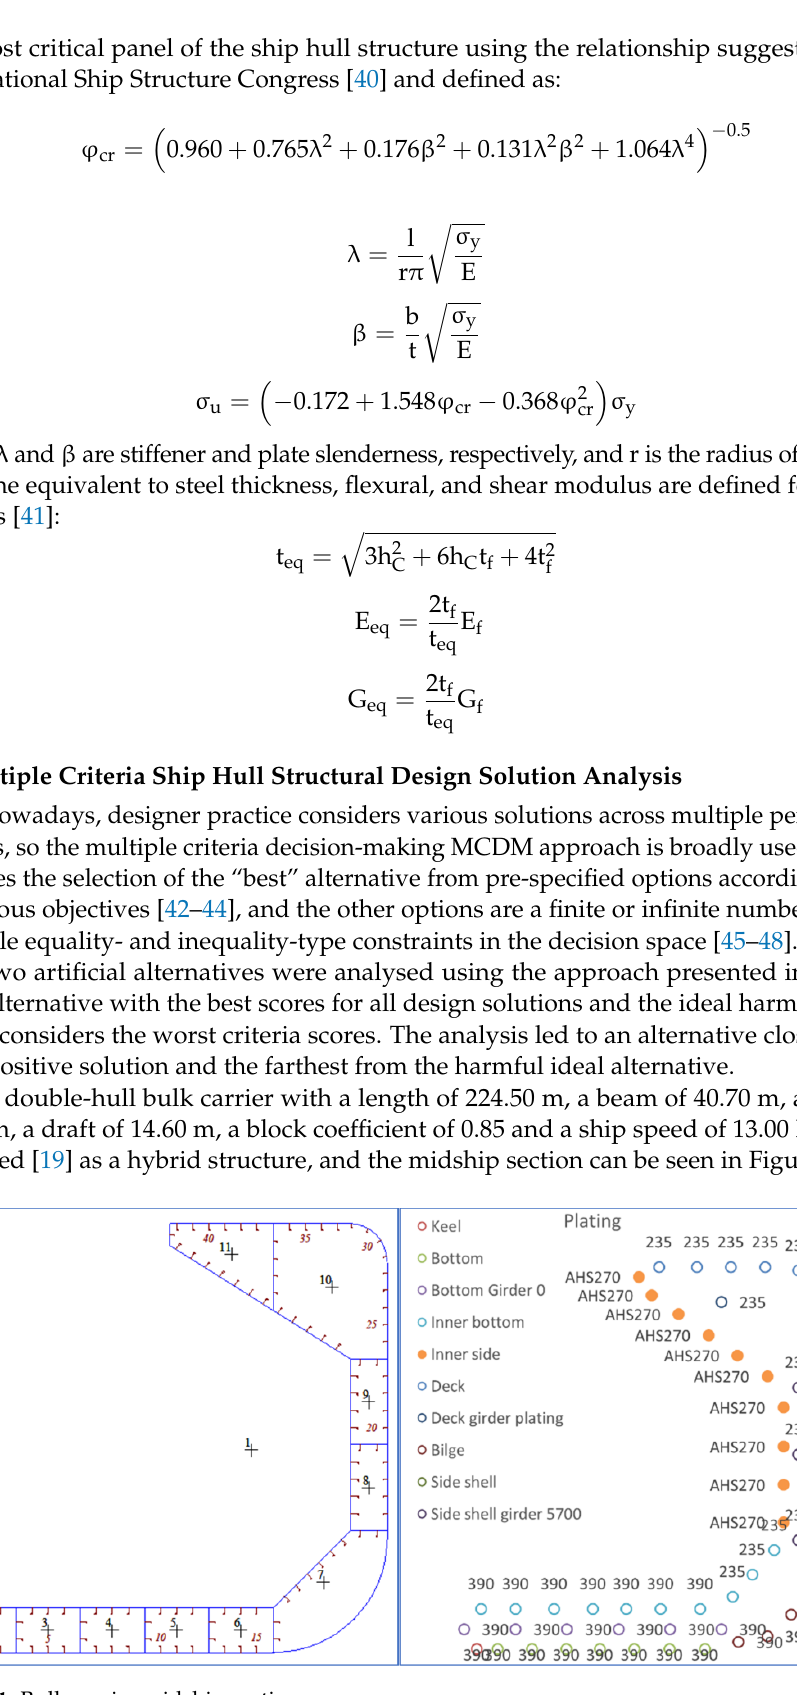
Figure 1. Bulk carrier midship section.